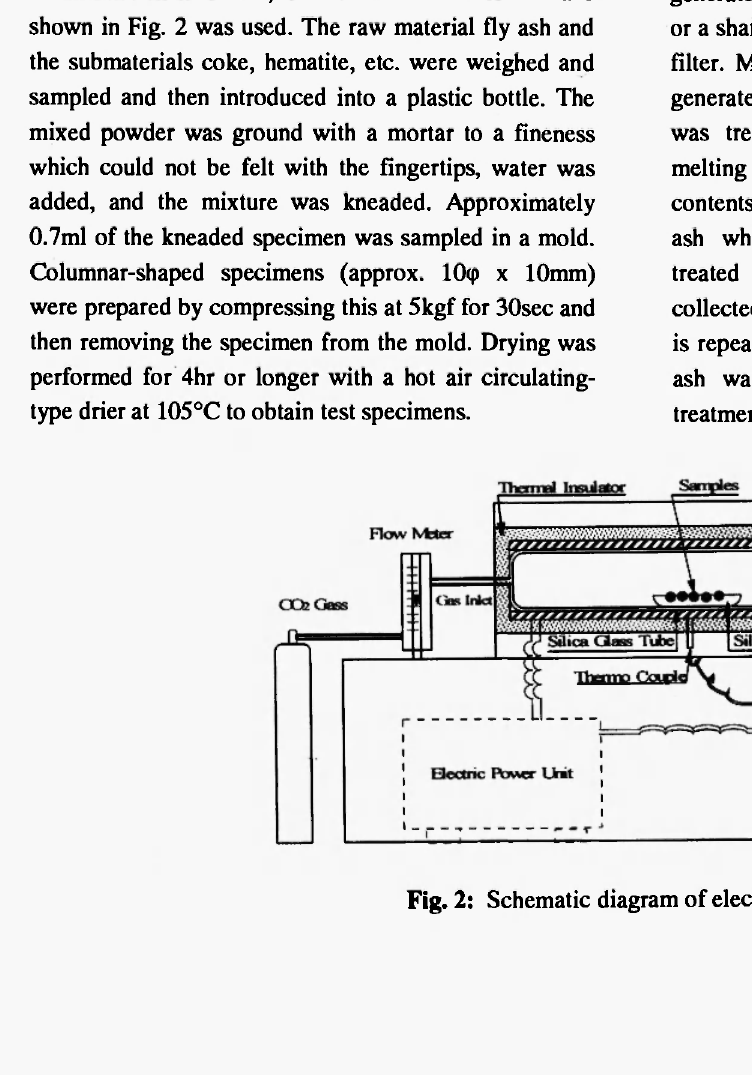
Fig. 2: Schematic diagram of electric